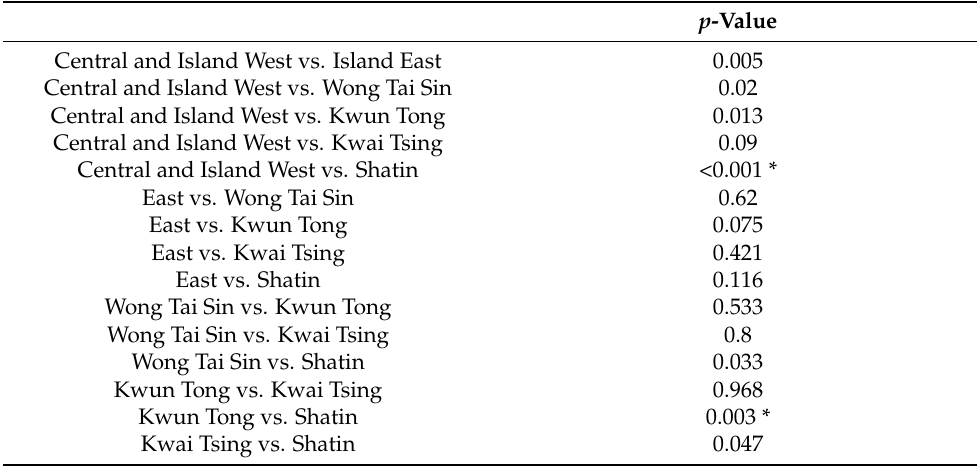
Table 7. Test with Bonferroni corrections for pairwise comparisons.